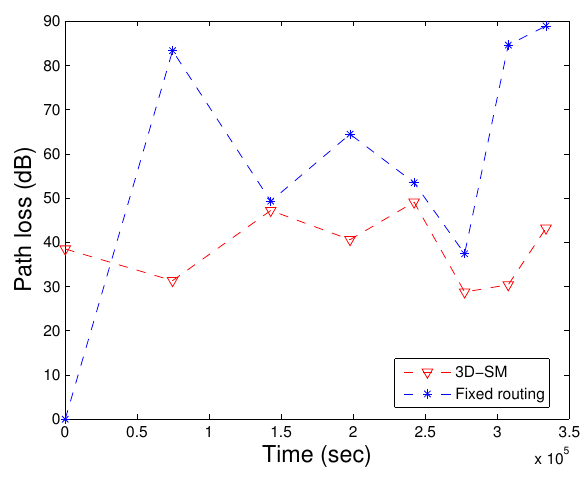
Figure 24. Path loss of fixed and dynamic routing.